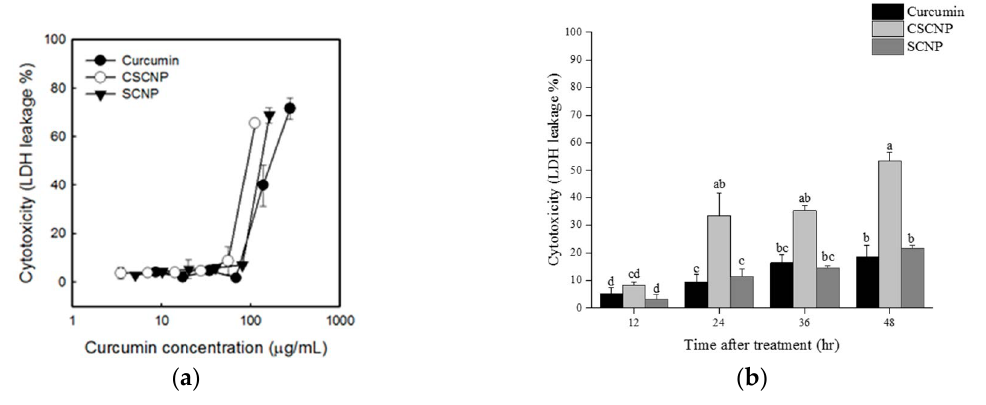
Figure 5. Lactate dehydrogenase (LDH) leakage of Hep G2 after different curcumin, or nanoparticle dosages and time durations. The cells were treated with samples for ( a ) 48 h at different dosage and ( b ) 100 μ g/mL at different times. The initial cell number was adjusted to 2 × 10 5 cells/mL. Data were shown by mean ± SD of three independent experiments ( n = 3) with three technical replicates. LDH: lactate dehydrogenase; SCNP: silica-encapsulated curcumin nanoparticles; CSCNP: chitosan with silica co-encapsulated curcumin nanoparticles.